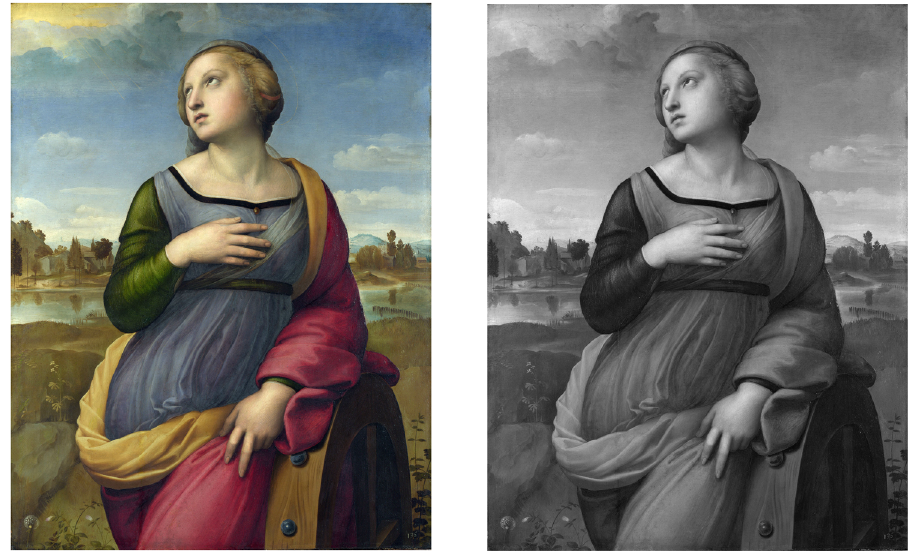
Figure 1: Raphael, 1507, St Catherine , National Gallery of London. Source: https://commons.wikimedia.org/w/index.php? curid =